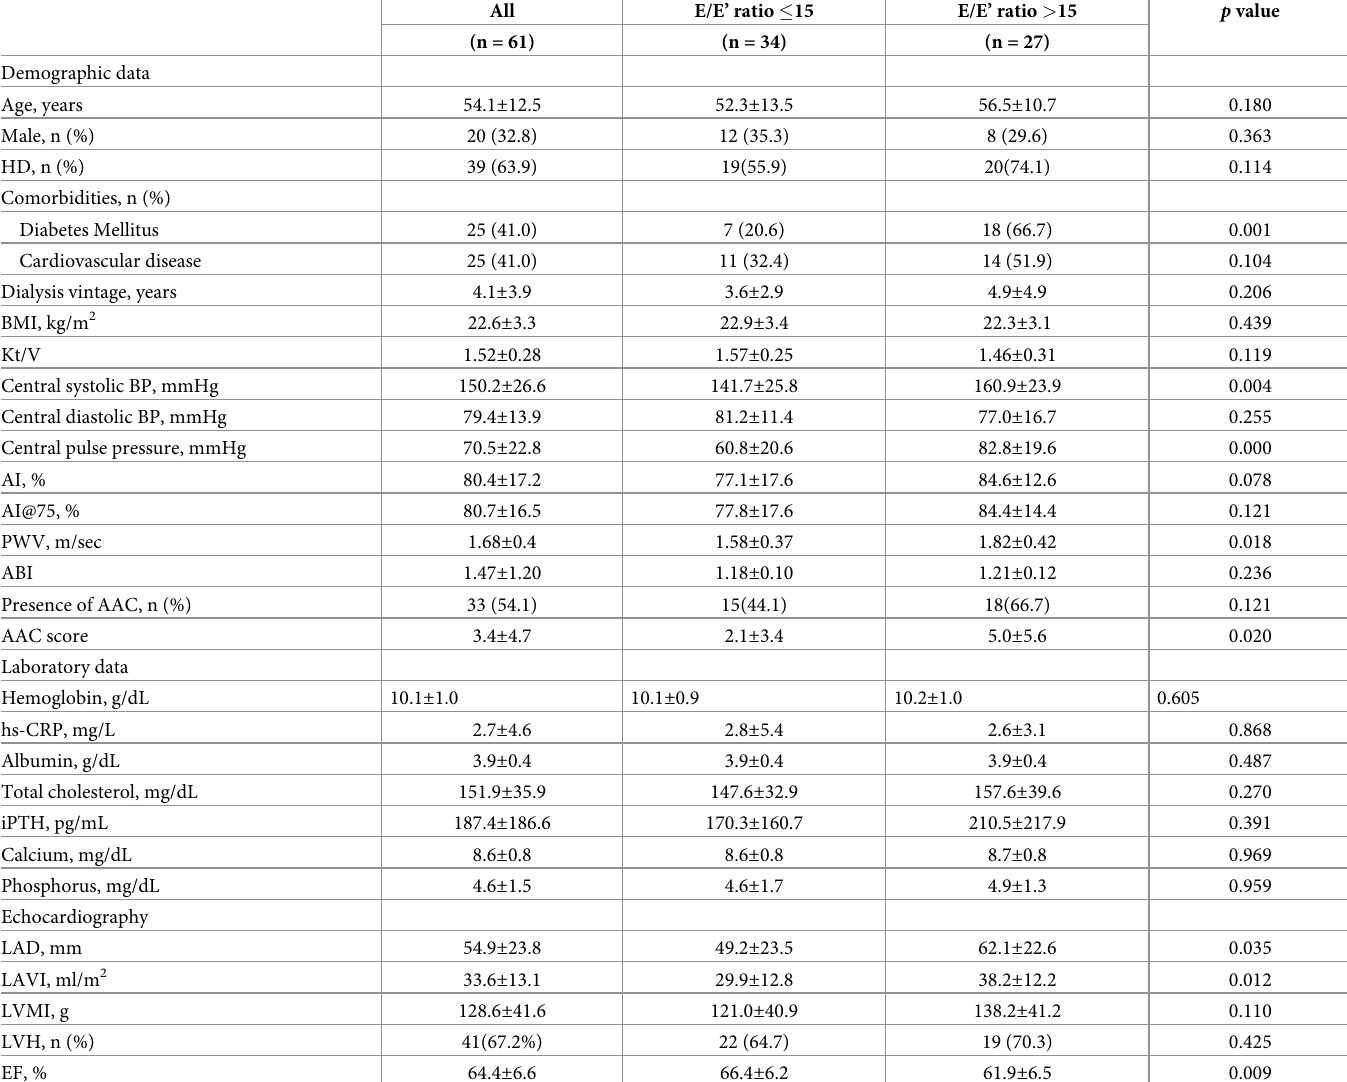
Table 1. Baseline characteristics of the study population according to E/E’ ratio at